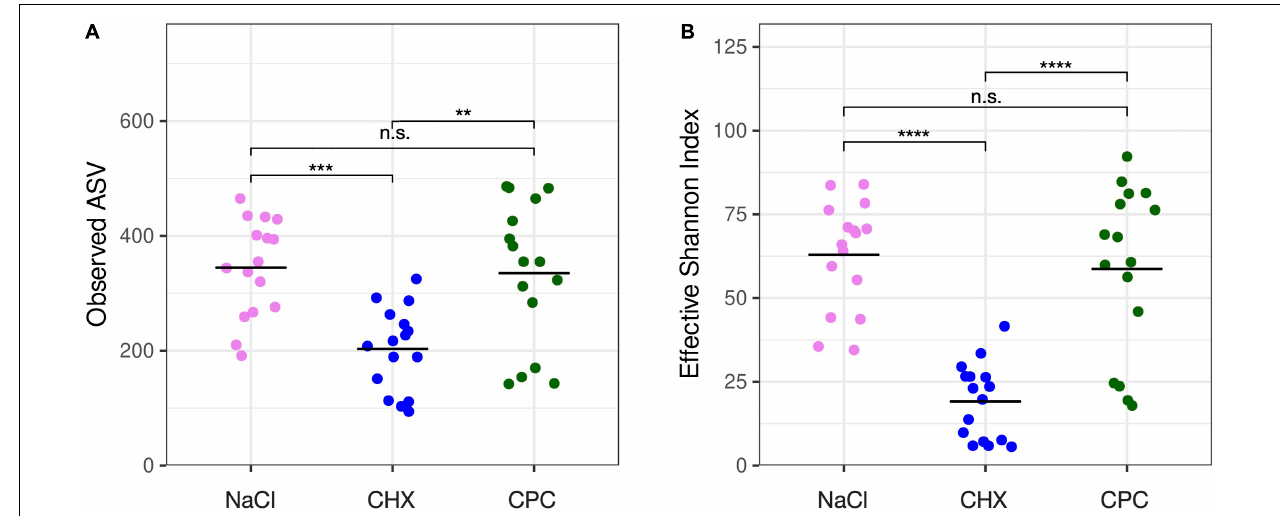
FIGURE 1 | Alpha-diversity of the biofilms as shown by observed ASVs (A) and effective Shannon index (B) . CHX-treated biofilms showed significantly lower alpha-diversity as compared to NaCl-treated or CPC-treated biofilms with no significant differences between the latter. Significance levels are indicated by asterisks: